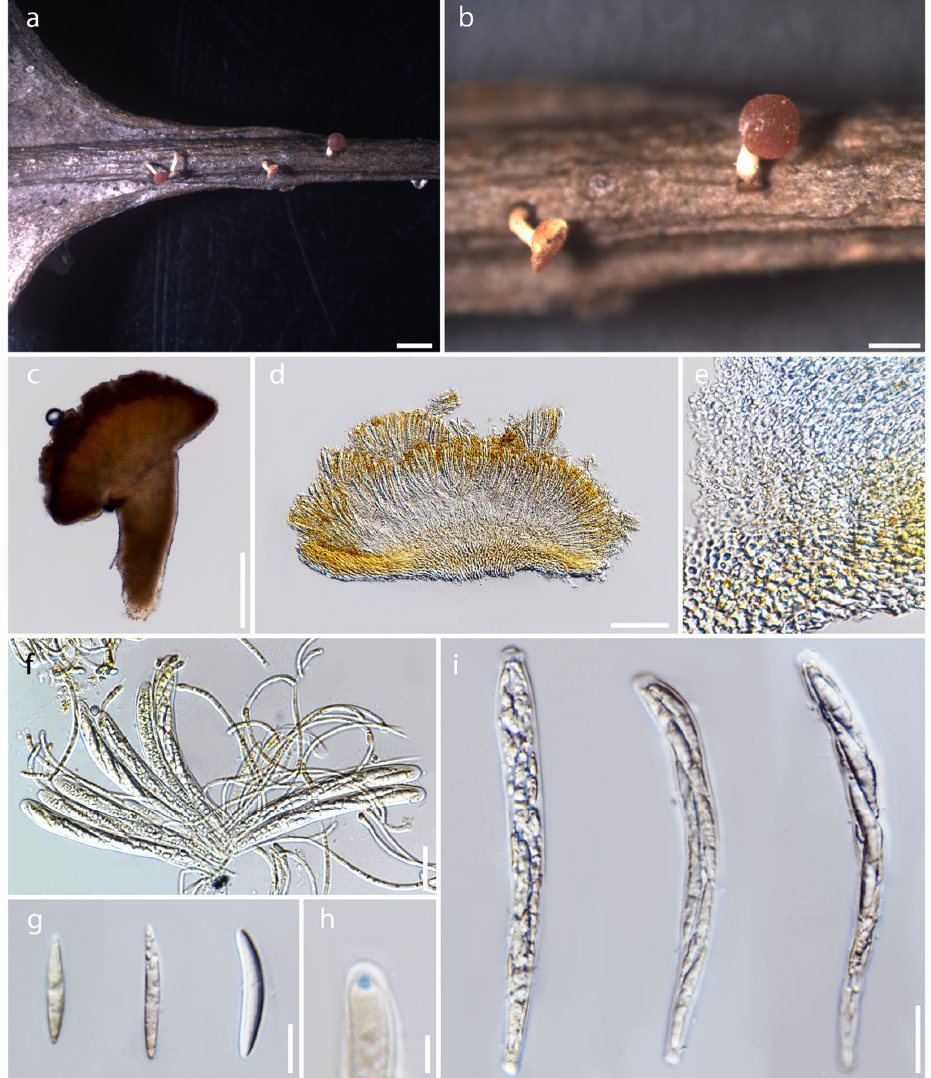
Figure 6. Dicephalospora inthanonensis (MFLU 22 ‐ 0050, holotype). ( a , b ) Dicephalospora species on a leaf; ( c , d ) cross section of the apothecium; ( e ) close up of the excipulum; ( f ) filiform paraphyses and asci; ( g ) fusiform ascospores; ( h ) apical part of ascus in Melzer’s reagent; ( i ) cylindrical asci. Scale bars ( a ) = 1 mm; ( b ) = 400 μ m; ( c ) = 200 μ m; ( d ) = 100 μ m; ( f , i ) = 20 μ m; ( g ) = 10 μ m; ( h ) = 5 μ